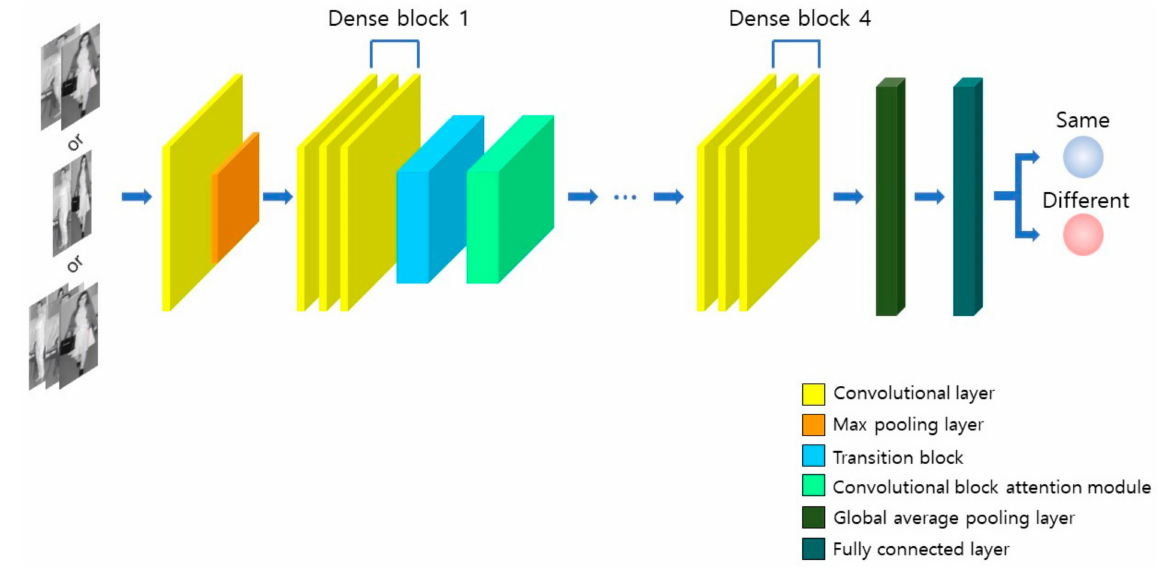
Figure 4. Architecture of attention-guided DenseNet.